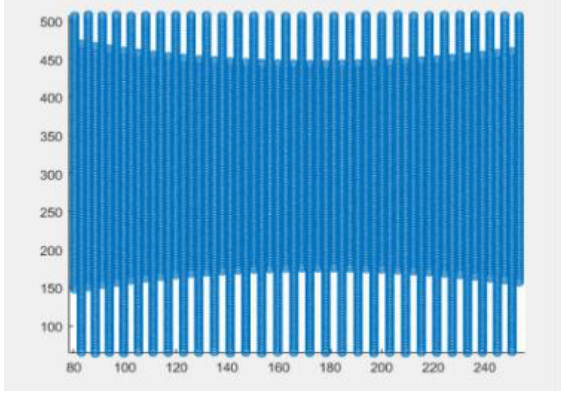
Figure 5. Local scan